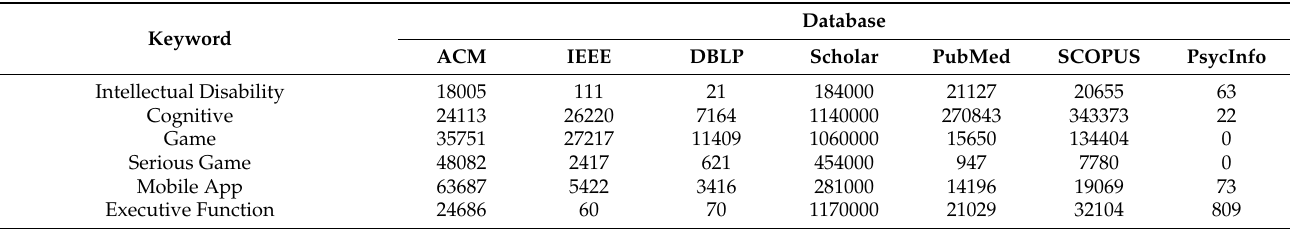
Table 2. Database search